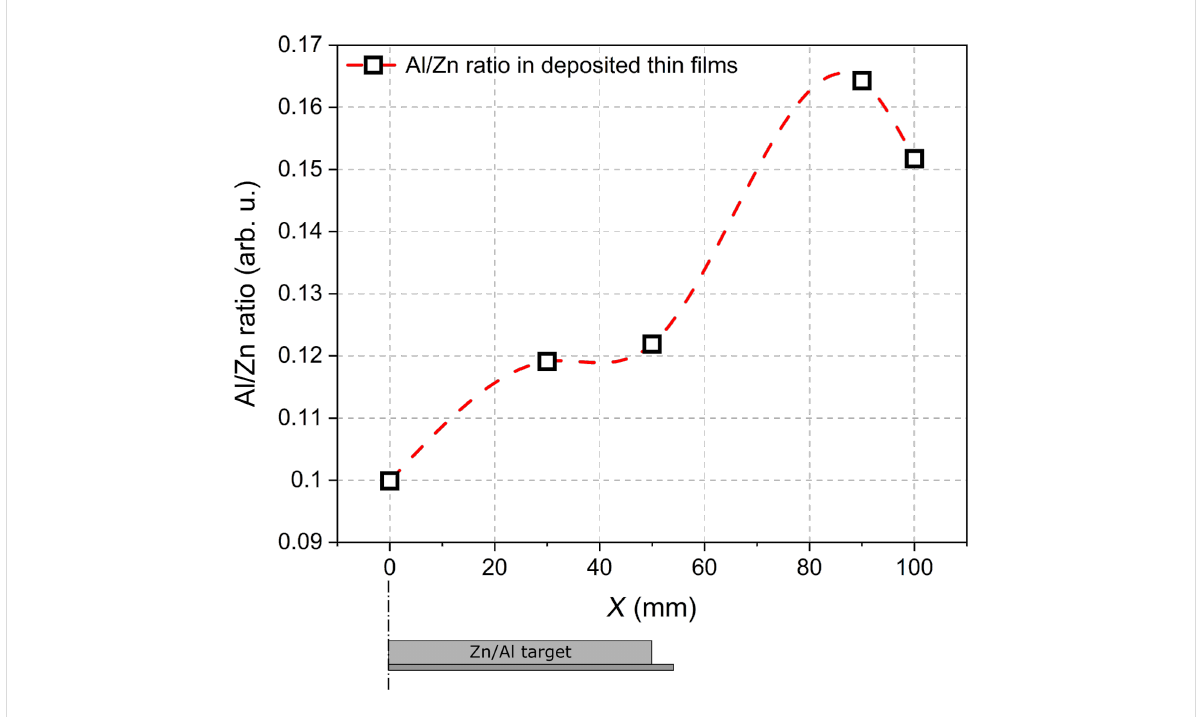
Figure 11: Al/Zn ratio in thin films deposited on the front side of the glass substrate as a function of the distance X from the Zn/Al target axis. The line is to guide the eye.